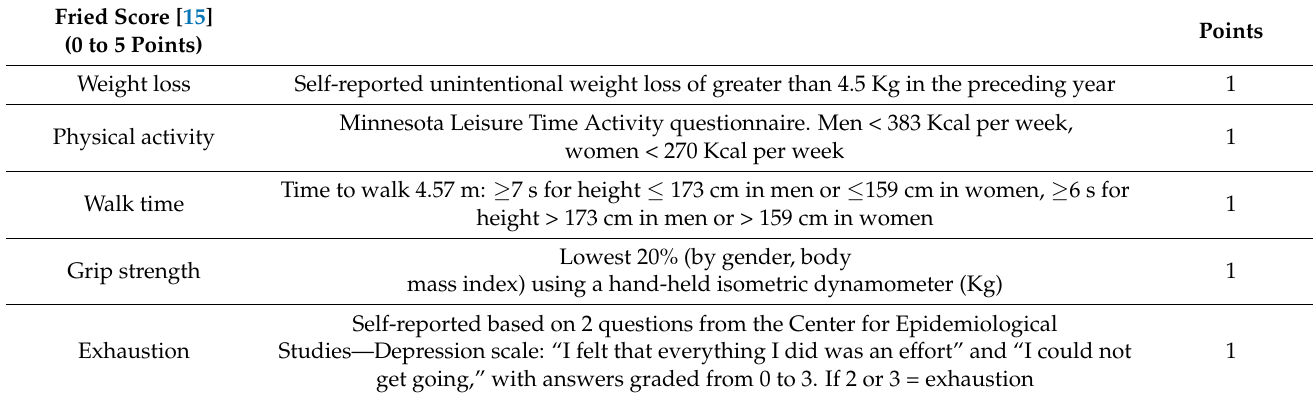
Table 1. Frailty assessment using the Fried